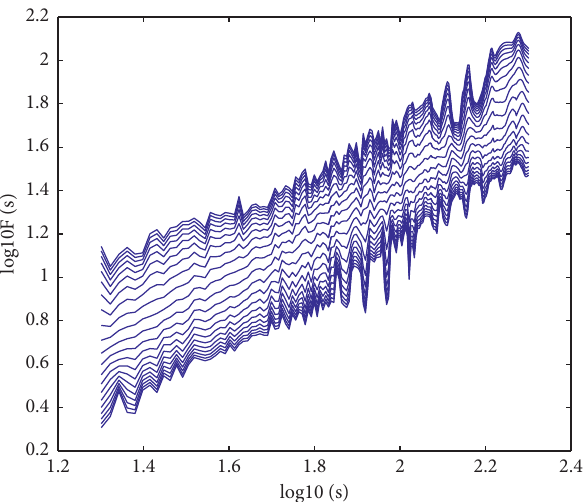
( m )) for GDCP and USEPU. cc